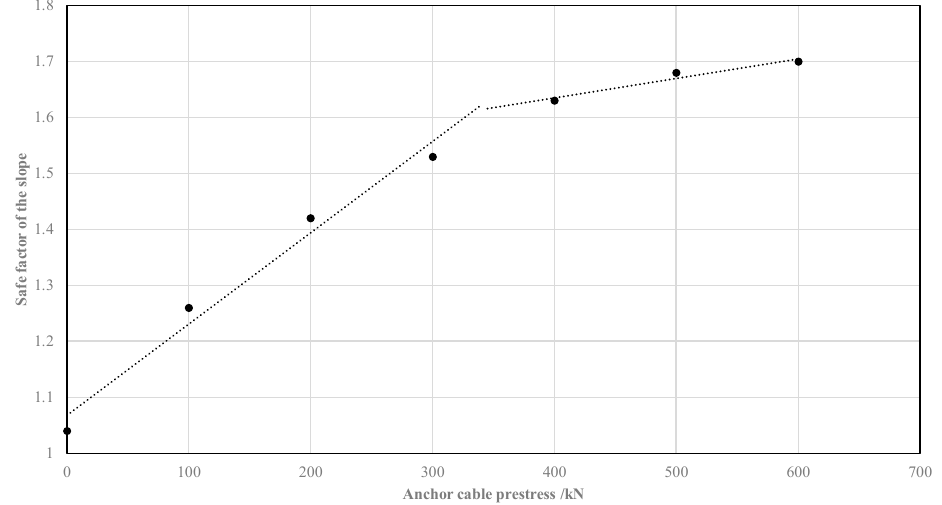
Figure 7. The relationship between the safety factor and the anchor cable prestress.